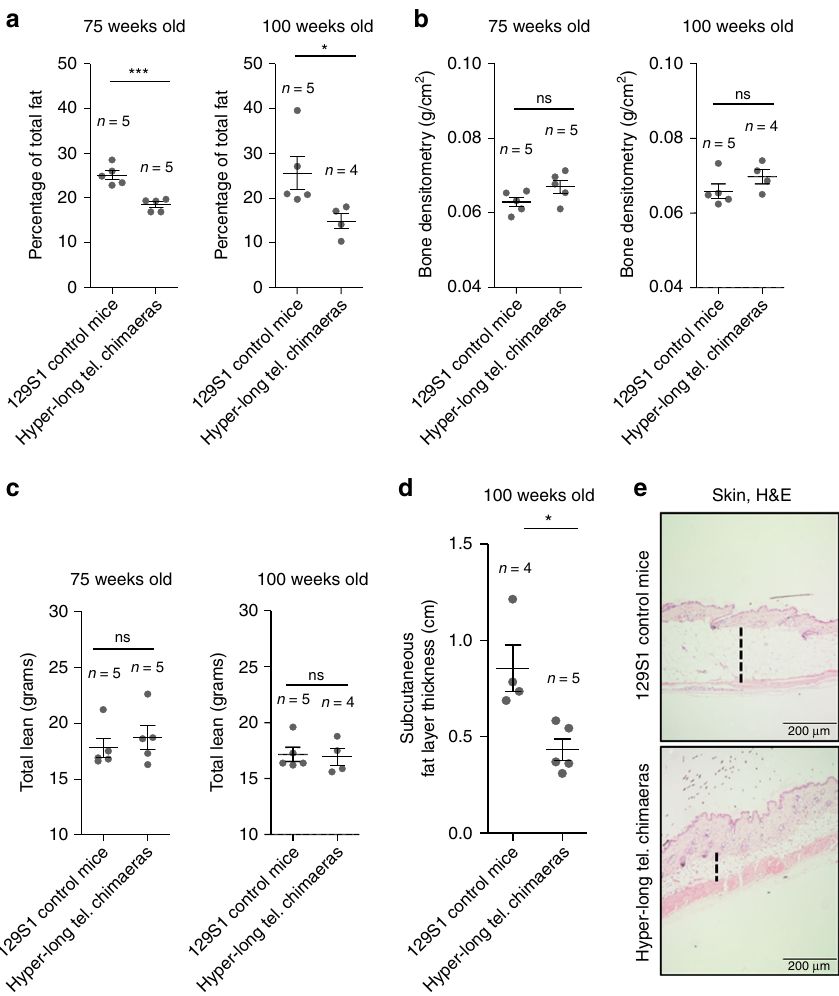
Fig. 2 Reduced body size in hyper-long telomere mice is due to lower fat accumulation. a – c Densitometry analysis of hyper-long telomere mice and normal mice at two different ages. a Quanti fi cation of percentage of total fat. b Quanti fi cation of bone density. c Quanti fi cation of total lean mass. d , e Quanti fi cation of the skin subcutaneous fat layer in 100 weeks-old hyper-long mice and age-matched controls ( d ), and representative image showing skin subcutaneous fat layer thickness. Measurements were done by ImageJ software and calculated by the mean value of 30 – 40 different measurements all over the skin subcutaneous fat layer. Error bars represent standard error. t -test was used for statistical analysis. The number of mice is indicated in each case. * p < 0.05. *** p < 0.001. Source data are provided as a Source Data fi